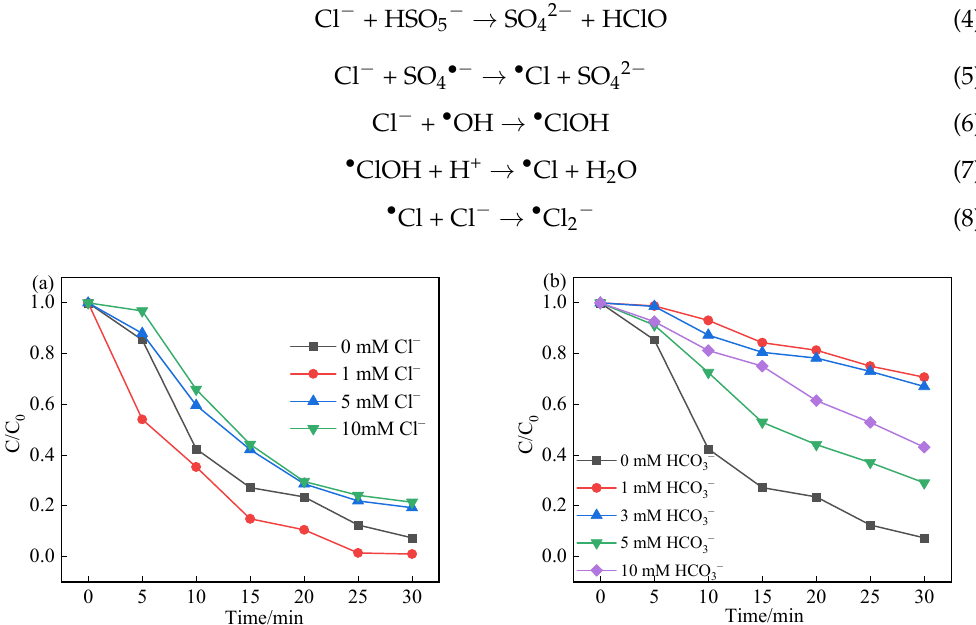
Figure 8. ( a ) Effect of Cl − on BPA removal; ( b ) effect of HCO 3 − on BPA removal. Conditions: C 0 = 0.05 mM, [LCFO-4] = 0.7 g/L, [PMS] = 10.0 mM, pH 0 6.8.